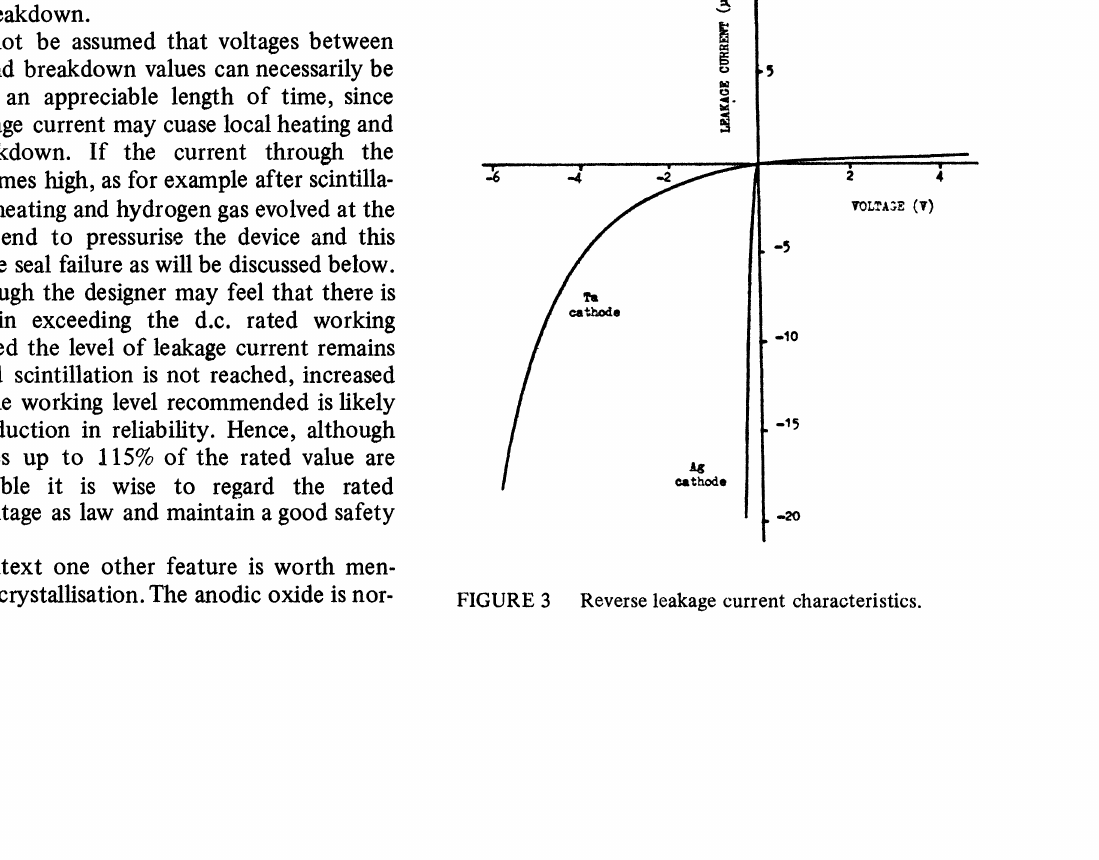
Reverse leakage current